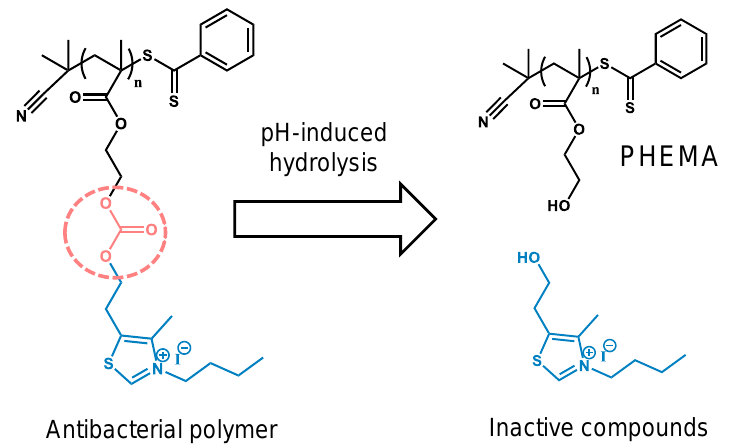
Scheme 1. Representation of antibacterial polymers containing pH-sensitive linkers.